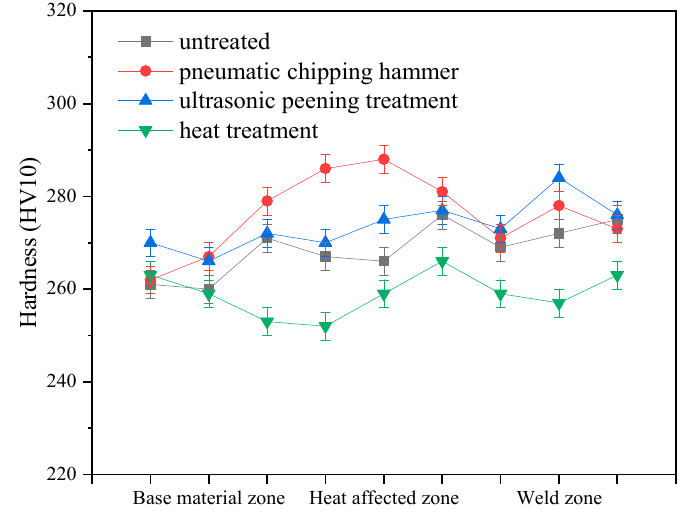
Figure 10. Hardness distribution of welded joints with different treatments.